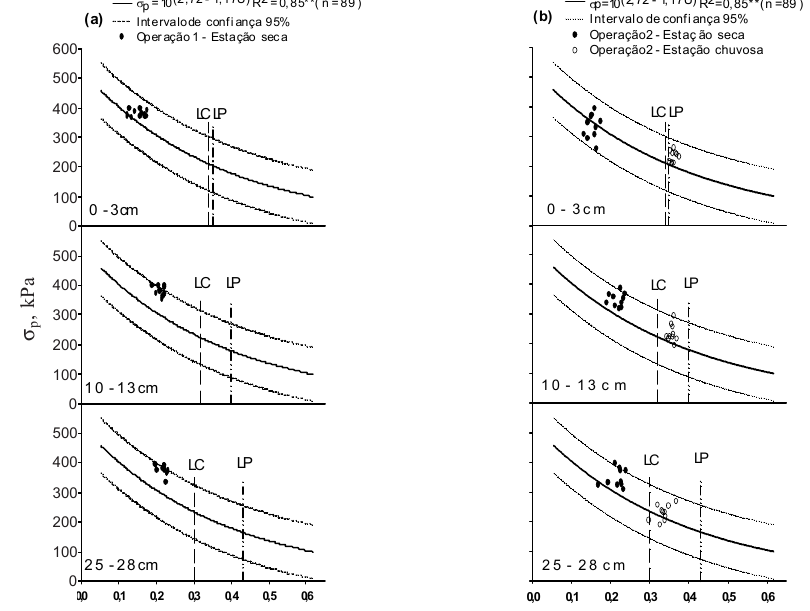
Figura 3. Modelo de capacidade de suporte de carga para o Latossolo Amarelo distrófico típico nas camadas de 0–3, 10–13 e 25–28 cm com seus respectivos limites de contração (LC) e de plasticidade (LP). Os pontos representam as pressões de preconsolidação determinadas após a Operação da colhedora tracionada pelo trator Massey Ferguson 275 na estação seca (Operação1) (a), pressões de preconsolidação determinadas após as operações do pulverizador tracionado pelo trator Massey Ferguson 265 na estação seca e na chuvosa (Operação 2)